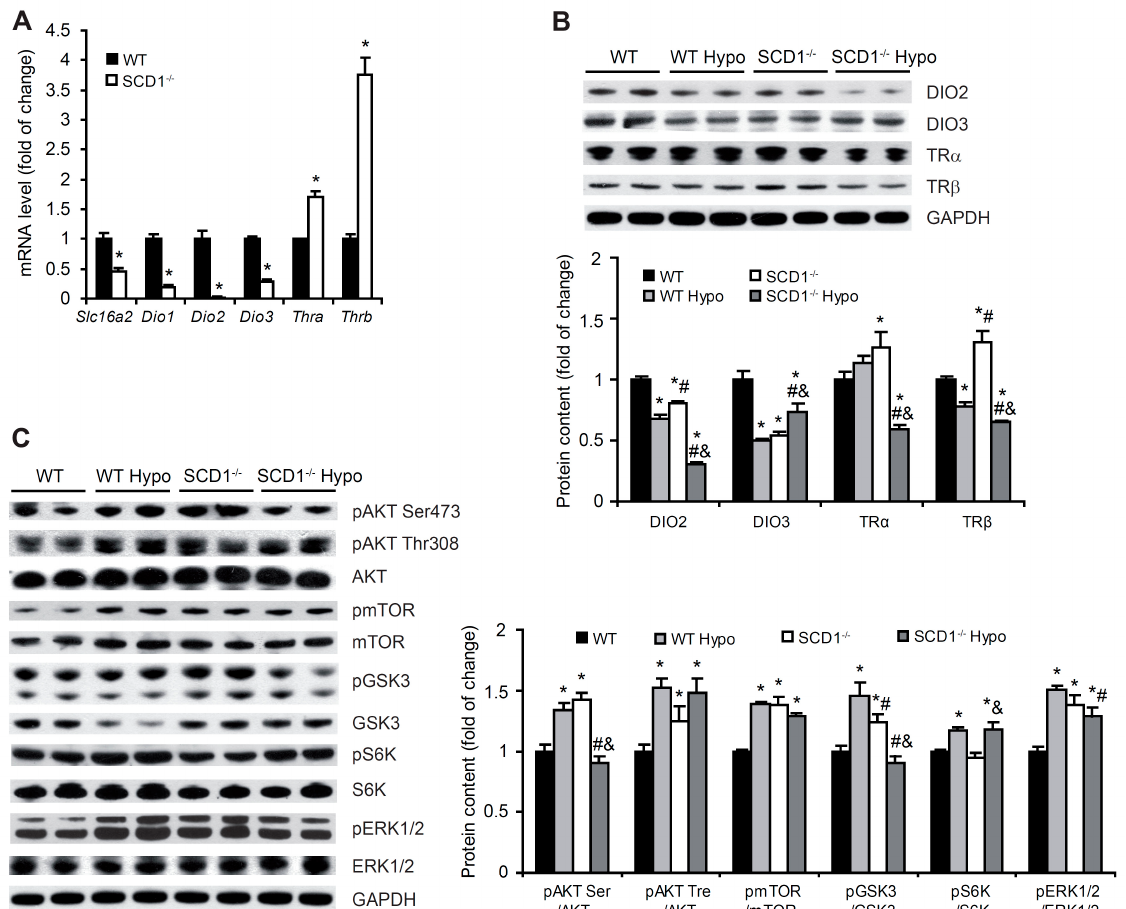
Figure 1. ( A ) Effect of SCD1 deficiency on the expression of genes that are involved in thyroid hormone actions. mRNA levels of Slc16a2 , Dio1 , Dio2 , Dio3 , Thra , and Thrb were determined in the heart in wildtype (WT) and SCD1 − / − mice by real-time polymerase chain reaction. ( B , C ) The levels of proteins that are involved in ( B ) genomic and ( C ) non-genomic thyroid hormone actions in the heart in control and hypothyroid mice were determined by Western blot. AKT, protein kinase B; mTOR, mechanistic/mammalian target of rapamycin; GSK3, glycogen synthase kinase 3; S6K, S6 kinase; ERK1/2, extracellular signal-regulated kinases 1/2; DIO, deiodinase; TR, thyroid receptor. The data are representative of n = 5 mice/group. The data are expressed as mean ± SD. * p < 0.05, vs. WT; # p < 0.05, vs. WT Hypo; & p < 0.05, vs. SCD1 − / −